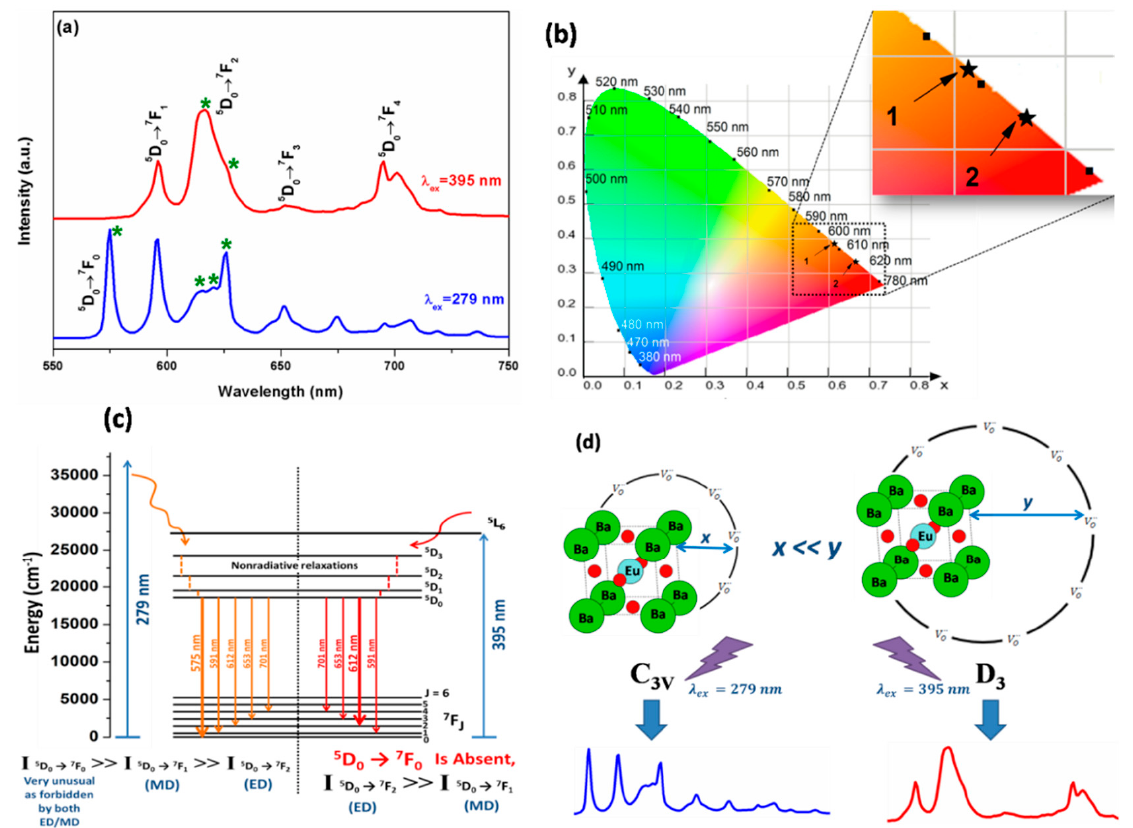
Figure 5. ( a ) Emission spectra of the BZOE-2 sample recorded at 77 K and ( b ) corresponding color coordinate diagram of the BZOE-2 sample under 279 and 395 nm excitations with * indicating the Stark components in ( a ) and arrows 1 and 2 pointing to the coordinates in ( b ), respectively. ( c ) Proposed photophysical processes happening under 279 and 395 nm excitations. ( d ) Schematic showing site selective excitations under 279 nm and 395 nm for the BZOE submicron crystals.